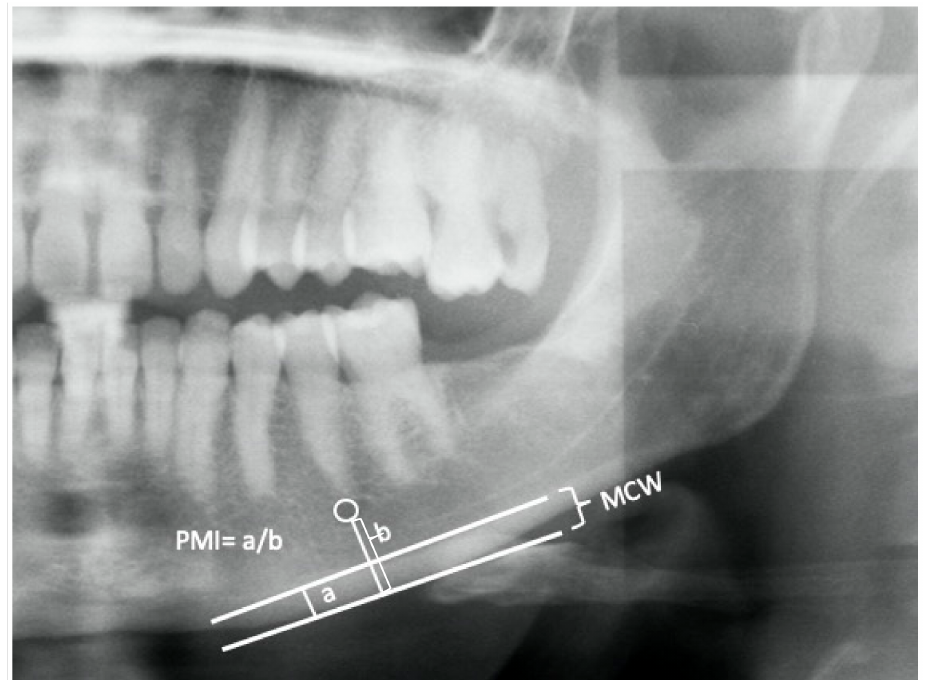
Figure 2. Mandibular cortical width (MCW) and panoramic mandibular index (PMI). The mandibular cortical width (MCW) is the distance between the inferior and superior cortex. The panoramic mandibular index (PMI) ratio is the ratio of the measurements of ( a ) the cortical thickness and ( b ) the point from the inferior border of the mental foramen (white circle) to the inferior border of the